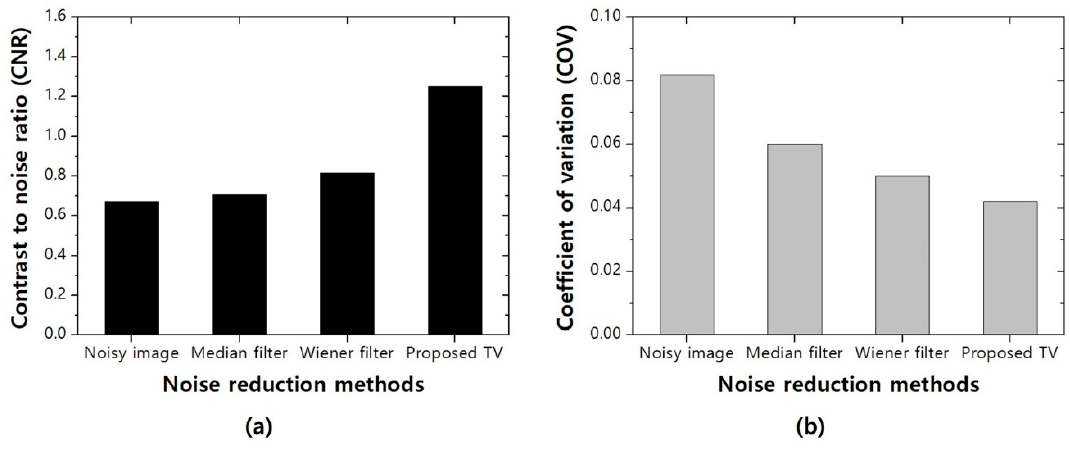
Figure 5. ( a ) CNR and ( b ) COV results (over ROI A and ROI B shown in Figure 2) obtained for the noisy image, median filter, Wiener filter, and proposed TV noise reduction algorithm applied to the confocal laser scanning micrograph of the tooth specimen. 162